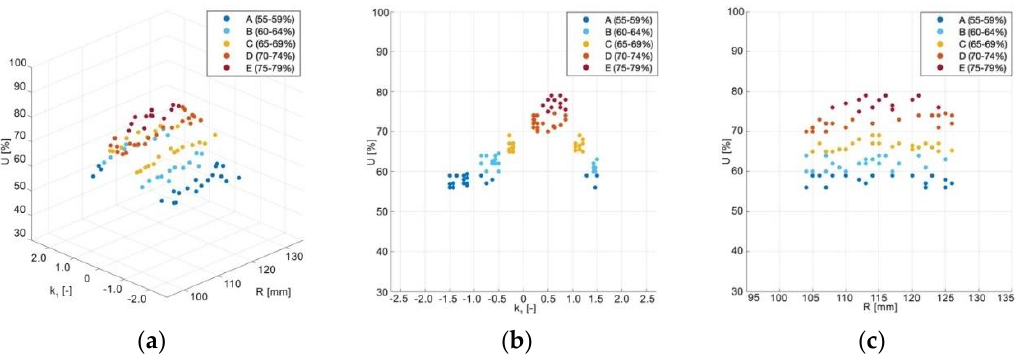
Figure 8. Dataset used in data-driven model: ( a ) overall view; ( b ) influence of the parameter k 1 on the uniformity of U ; and ( c ) influence of the parameter R on the uniformity of U.